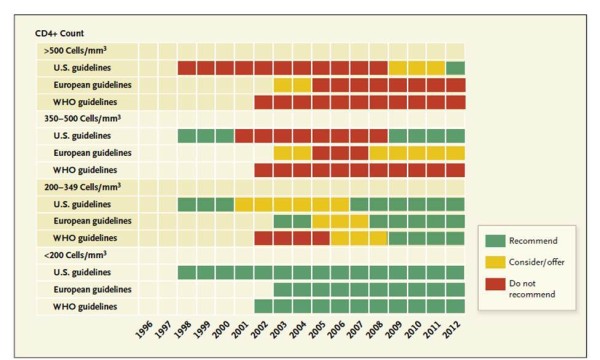
When to start HAART among asymptomatic HIV + patients according to guidelines: 1998 to 2012. Criteria from the United States are derived from the IAS-USA Treatment Guidelines and the Department of Health and Human Services Guidelines for Antiretroviral Therapy for Adults and Adolescents; European guidelines are derived from the European AIDS Clinical Society (EACS) Guidelines; and the World Health Organization (WHO) Guidelines are from the WHO Antiretroviral Therapy Guidelines for Adults and Adolescents. Adapted with permission from Dr. Marco Vitoria, MD of the World Health Organization and the Massachusetts Medical Society/New England Journal of Medicine [50].